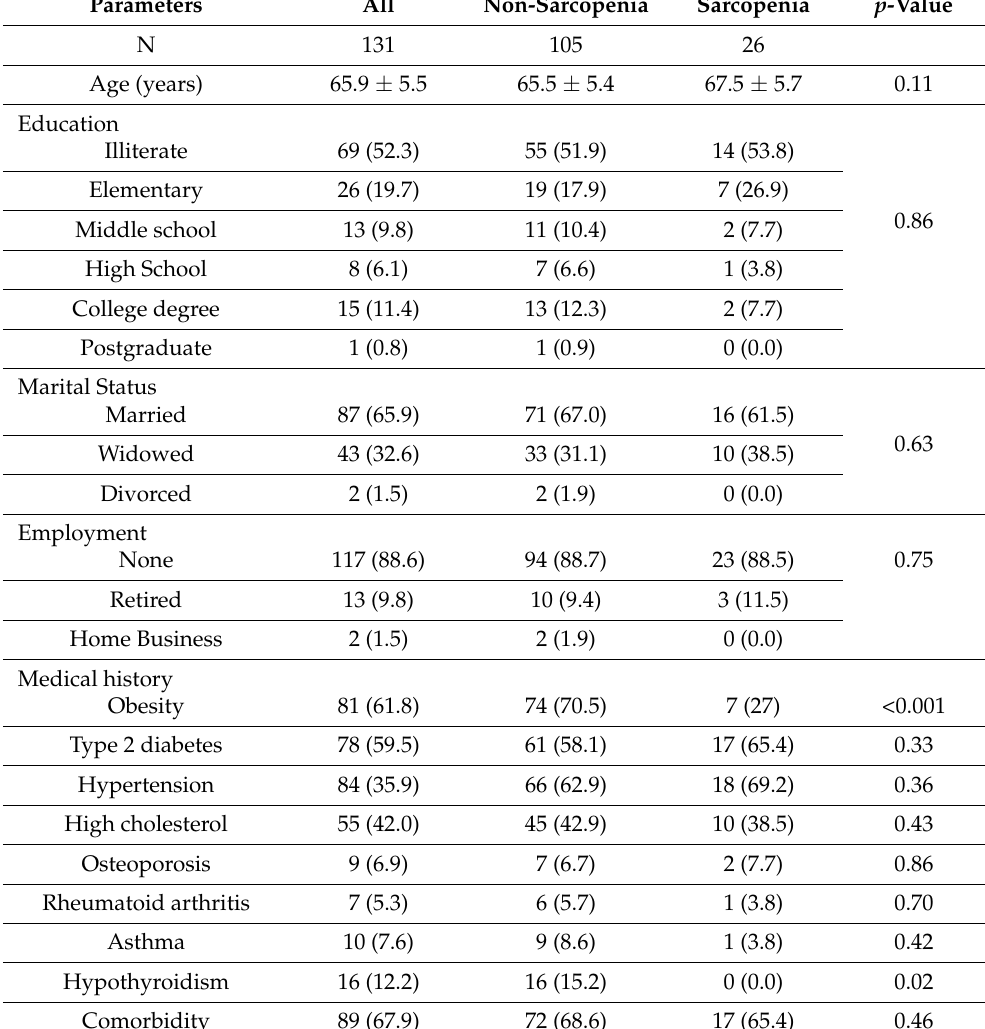
Table 1. General characteristics of participants according to sarcopenia